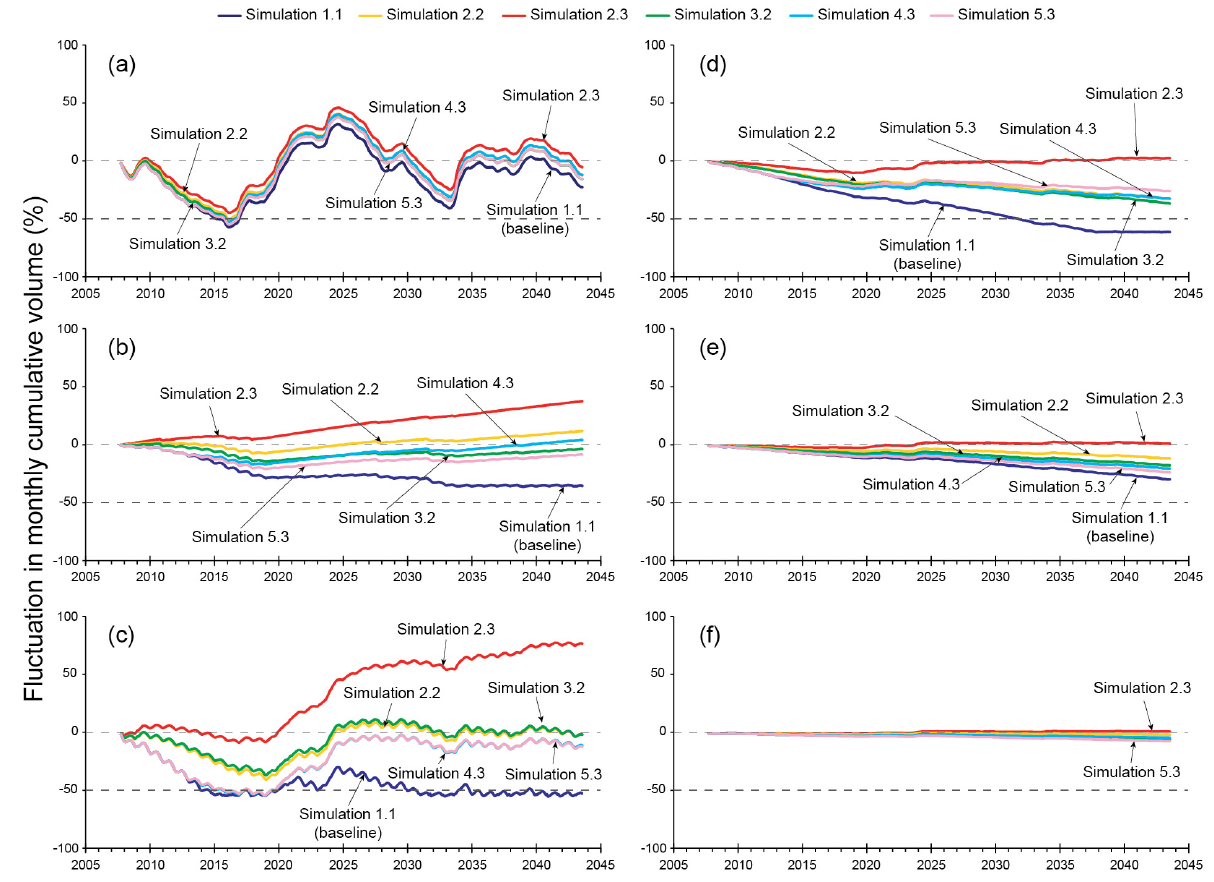
Figure 6. Fluctuations in monthly cumulative volume (%) in the administrative aquifer sectors for different simulations. ( a ) Aquifer Sector 1; ( b ) Aquifer Sector 2; ( c ) Aquifer Sector 3; ( d ) Aquifer Sector 4; ( e ) Aquifer Sector 5; ( f ) Aquifer Sector 6. The reference (null) volume corresponds to